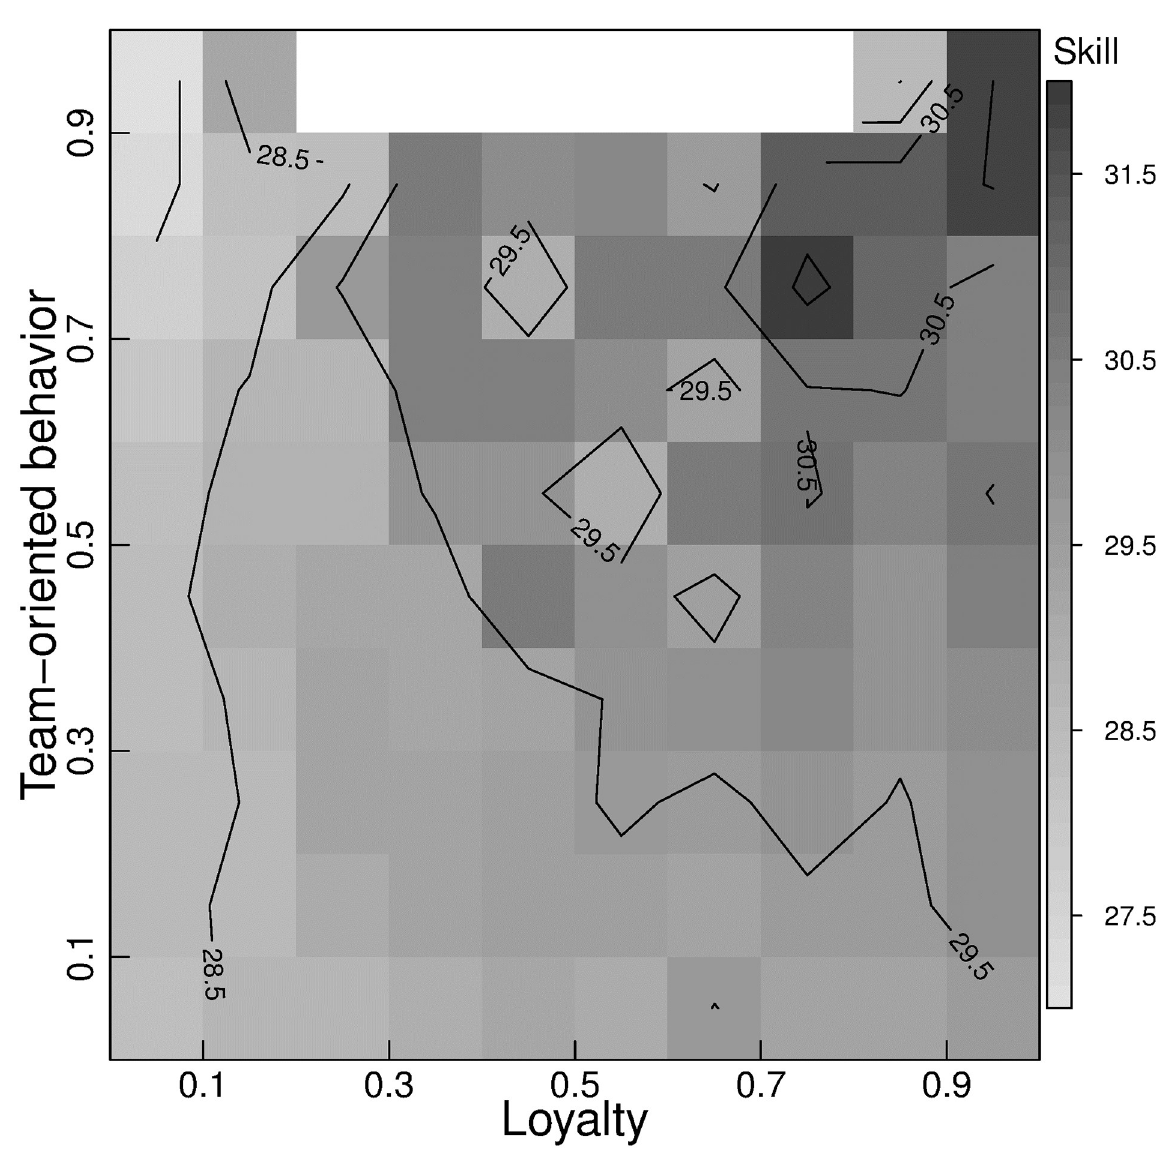
Fig 4. Skill interaction between loyalty and TOB for all players. The role of experience was isolated by taken the skill of players at the same point of experience. All players have 100 of games played. The average skill of each bin is reported by the gray-scale. Contour lines are shown. Empty bins have less than five